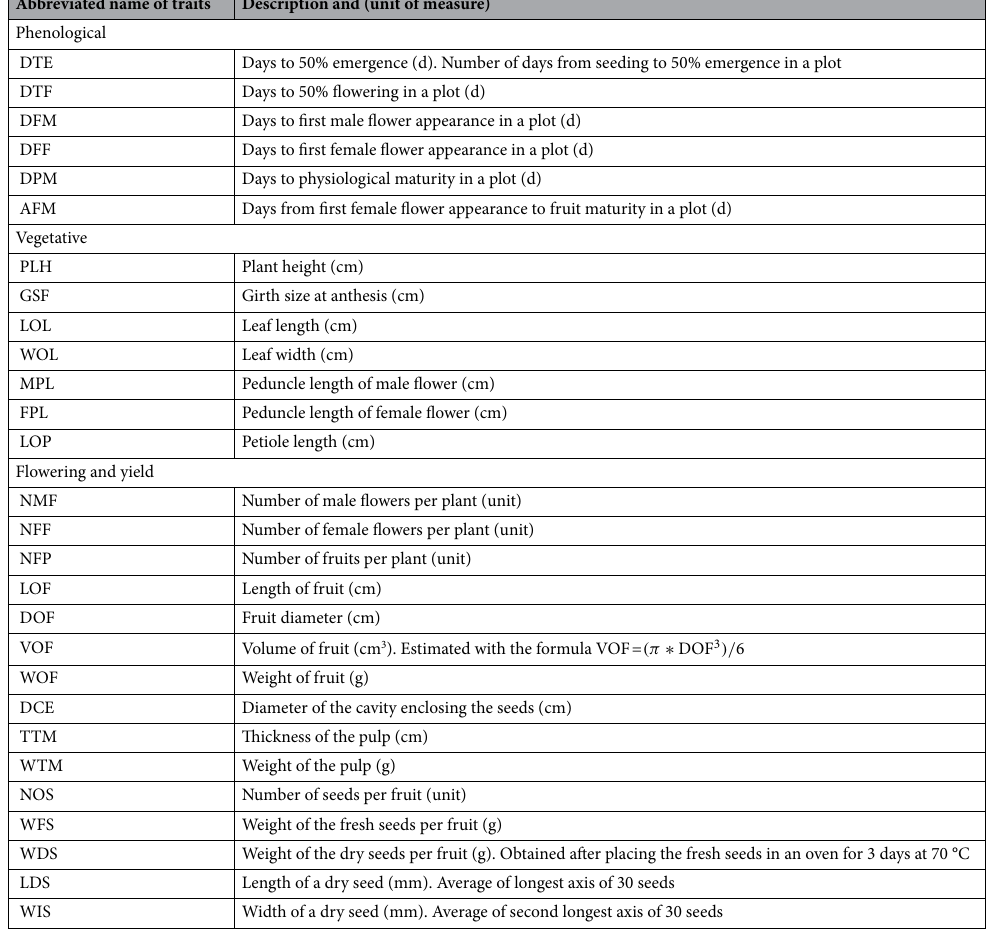
Table 5. Phenological, vegetative and flowering and yield traits of C. moschata assessed in this study, along with their descriptions and unit of measure in